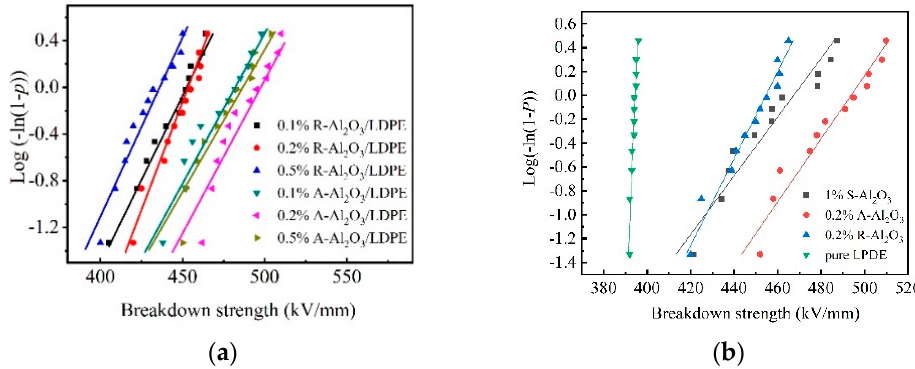
Figure 4. The breakdown strength of Al 2 O 3 /LDPE composites with the thickness of 50 ± 5 μ m ( a ) different content of R-Al 2 O 3 /LDPE and A-Al 2 O 3 /LDPE; ( b ) pure LPDE and three different types of Al 2 O 3 /LDPE composites.